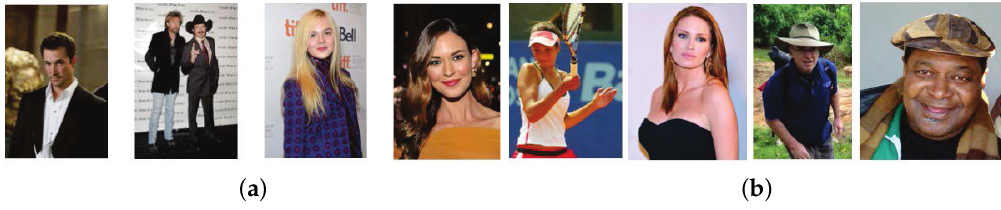
Figure 2. Sample images from datasets from the Internet Movie Database (IMDB) and Wikipedia (WIKI). ( a ) IMDB; ( b ) WIKI.